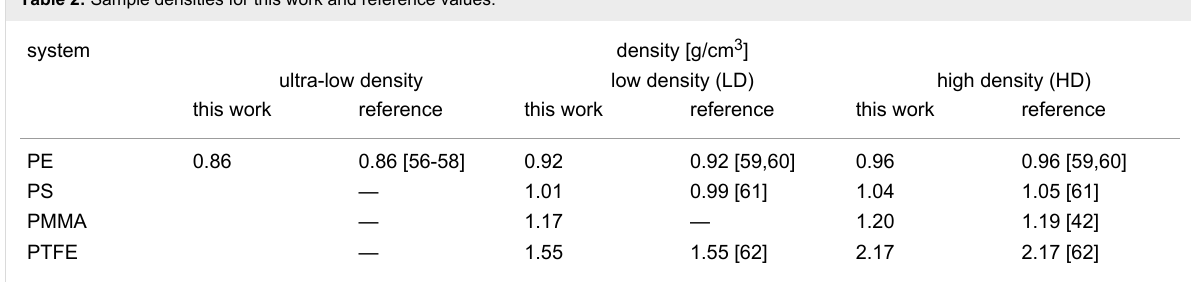
Table 2: Sample densities for this work and reference